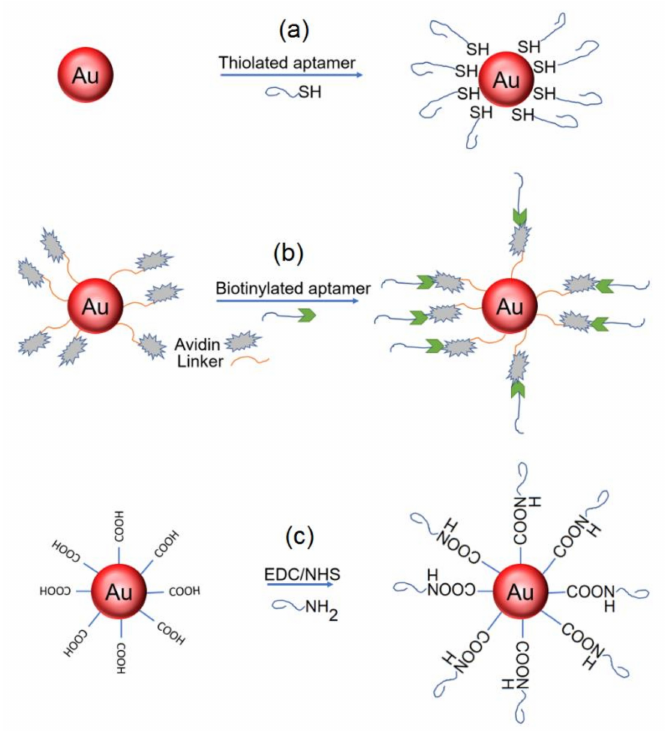
Figure 4. Scheme of the most common methods of AuNPs modification by DNA aptamers. ( a ) chemisorption of thiolated aptamers; ( b ) adsorption of biotinylated aptamers onto avidin covered NPs; ( c ) conjugation of amino-modified aptamers onto the surface of NPs covered by carboxylic groups activated by carbodiimide method. EDC-N-(3-Dimethylaminopropyl)-N’-ethylcarbodiimide hydrochloride,